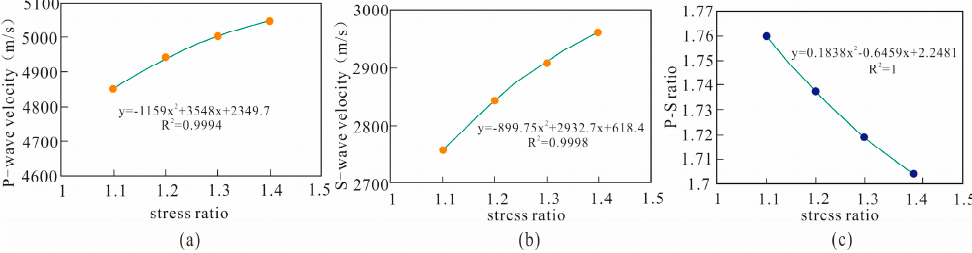
Figure 9. Relationship curves between the P − wave velocity, S − wave velocity, S − wave ratio and stress ratio.